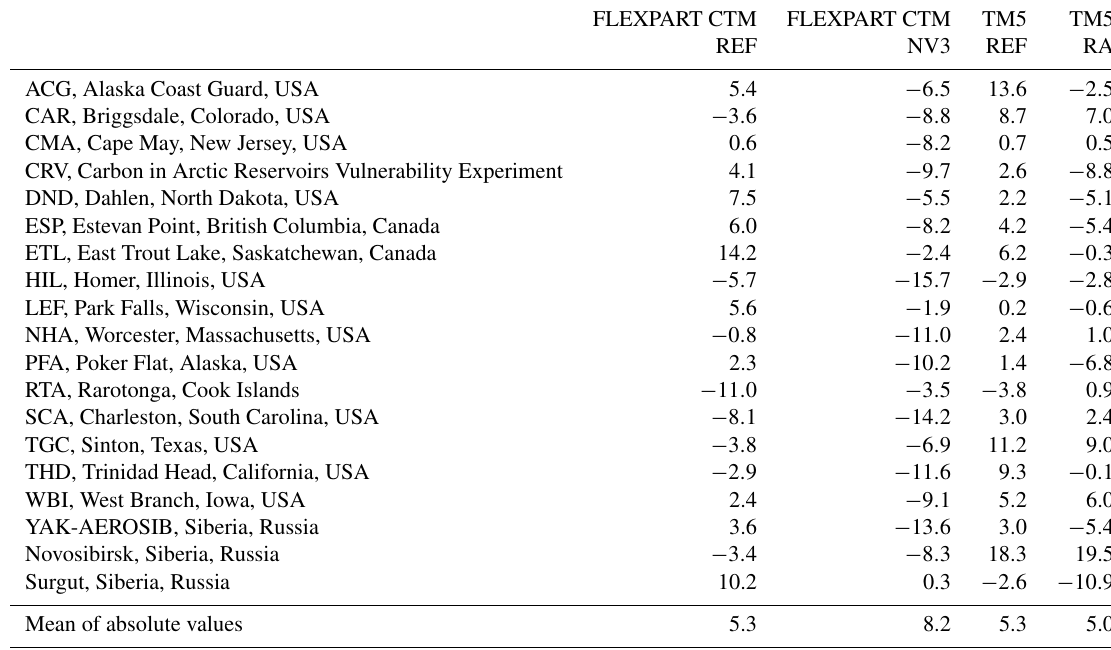
Table 6. Bias (ppb) of averaged methane profiles at NOAA and NIES profile sites and during the YAK-AEROSIB flight campaign. Bias is determined with equal weight of each vertical layer.